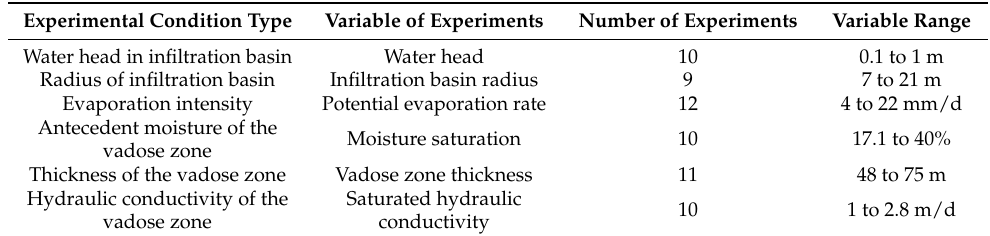
Table 1. The experimental condition type, variable of experiments, number of experiments, and variable range of homogeneous domain experimental conditions.